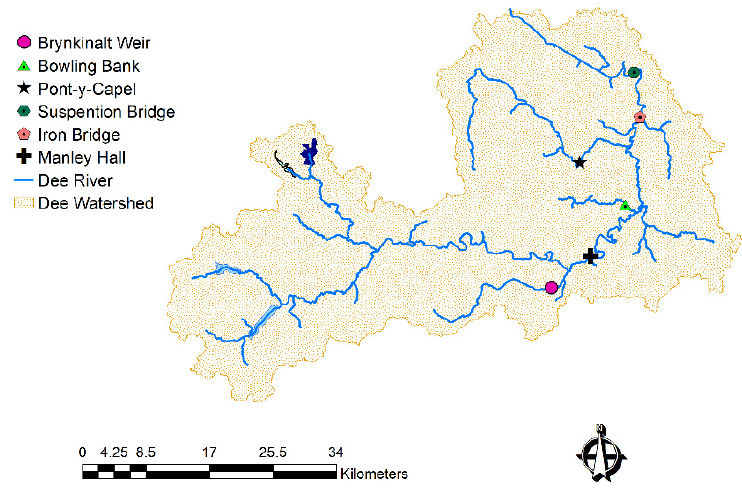
Figure 9. Locations of the main inlets and the river gauge stations in the Dee River basin.